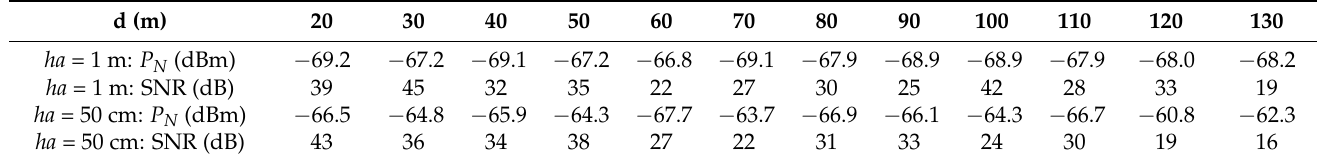
Table 6. SNR and background noise power (P N ) for each ha of 1 m and 50 cm at each